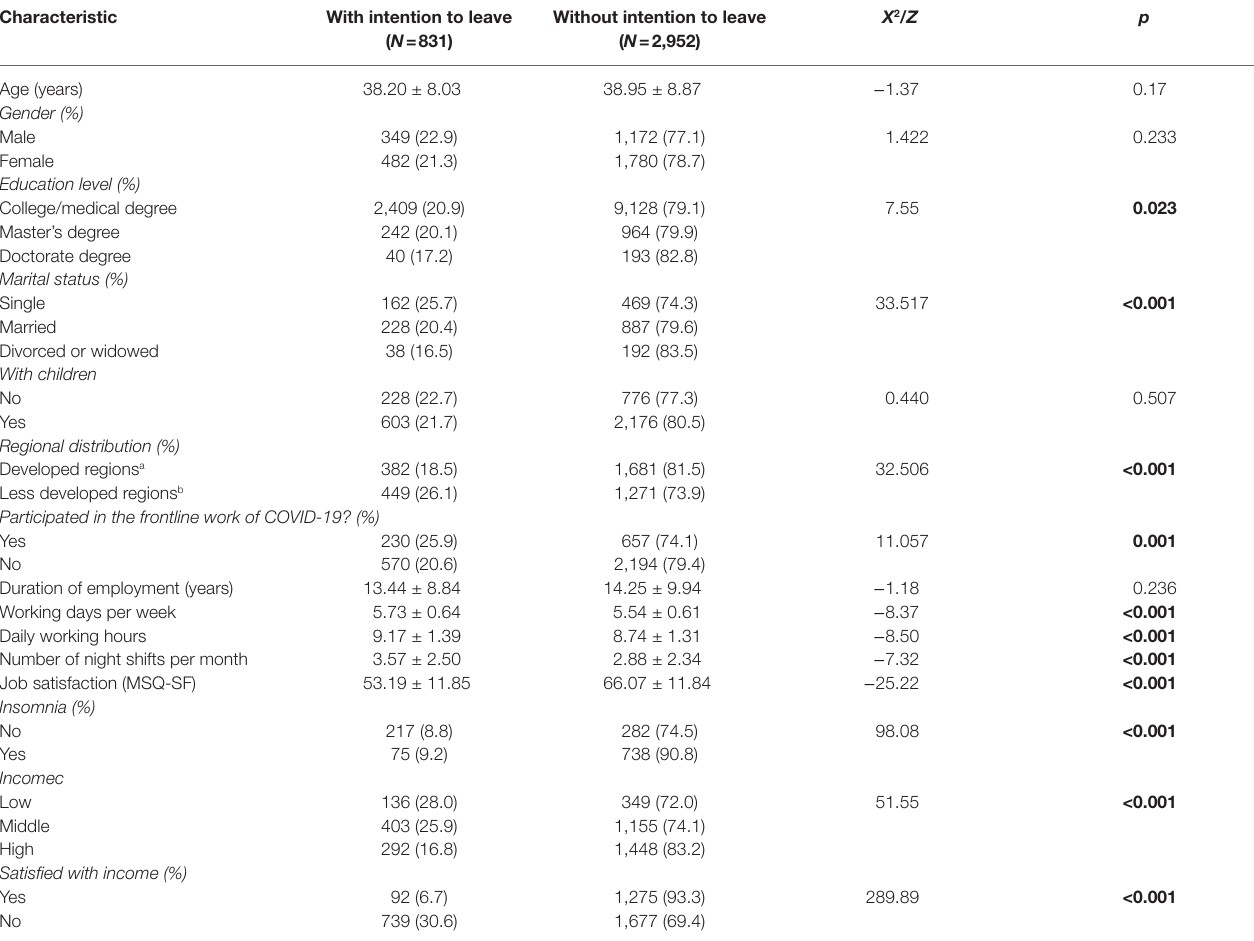
TABLE 2 | Comparison of socio-demographic characteristics and work-related factors between of psychiatrists with intention and without intention to leave. Characteristic With intention to leave Without intention to leave ( N = 831) ( N = 2,952)